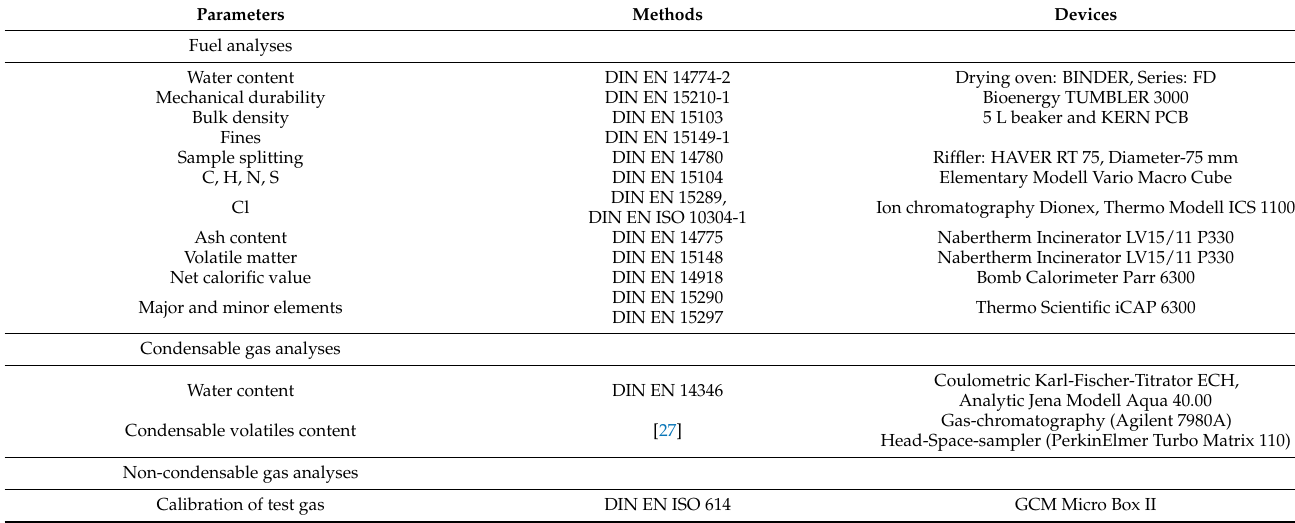
Table 2. Overview of the methods and the devices used in this study.